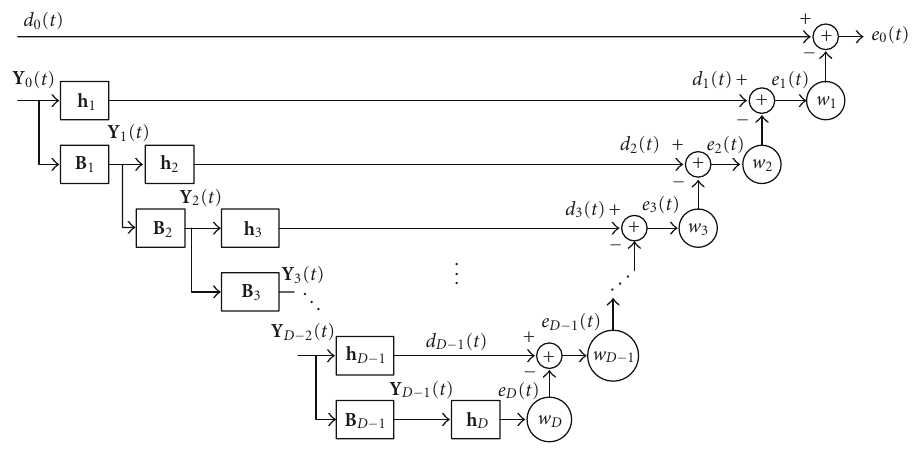
Figure 4: Multistage Wiener